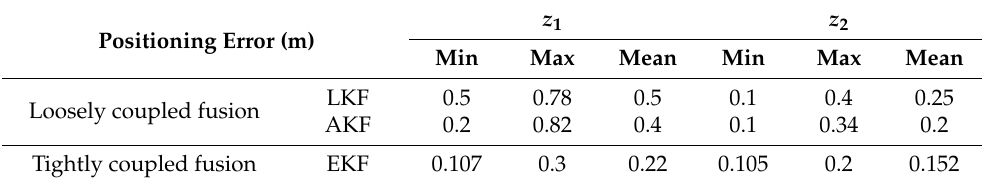
Table 8. Summary of errors for 90% of the estimated positions for the different considered fusion methods.